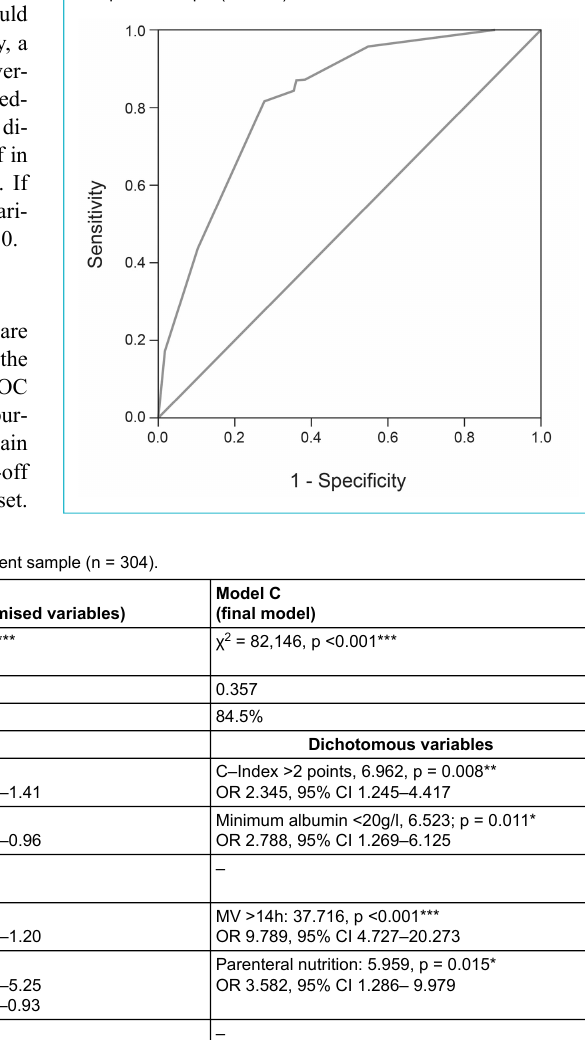
Figure 2: Receiver operating characteristic of the risk score in de- velopment sample (n = 304)